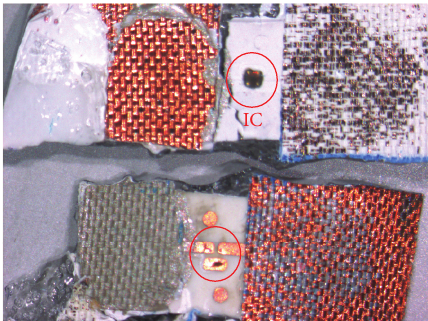
Figure 9: The IC fixture of a broken tag: the IC has been ripped off from the IC fixture and attached to the coating material; mag- nification is × 6.3.